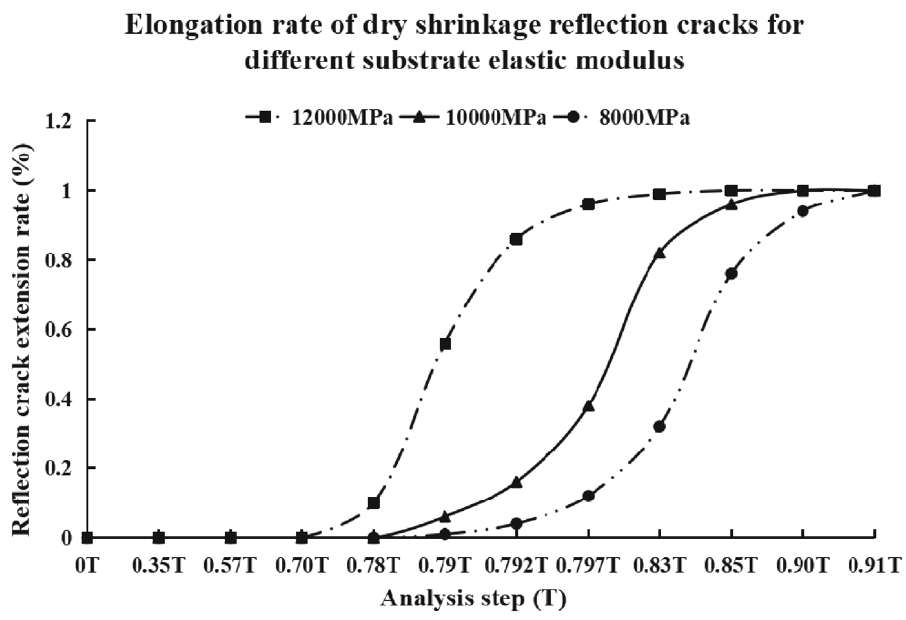
Fig. 8 Elongation rate of dry shrinkage reflection cracks for different substrate elastic